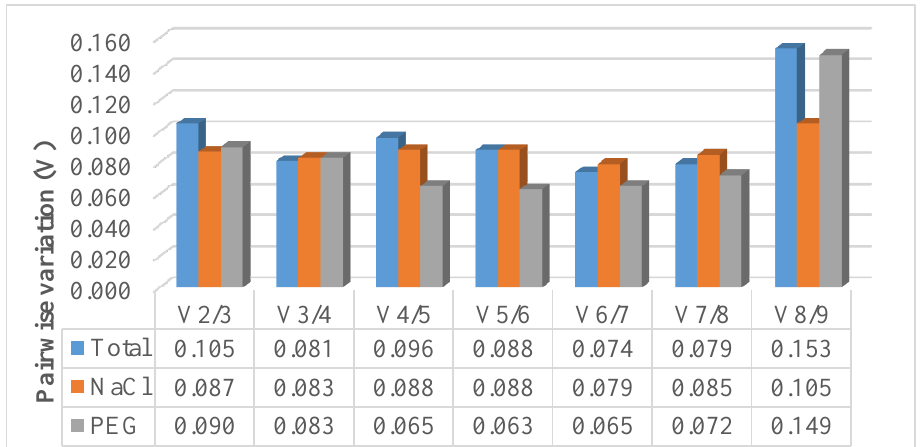
Figure 5. Determination of optimal number of reference genes calculated by geNorm. Pairwise variation (V n / V n + 1 ) below 0.15 indicates no significant contribution made by inclusion of additional reference gene. Analysis was performed for NaCl treated samples (NaCl), PEG treated samples (PEG) and all samples combined together